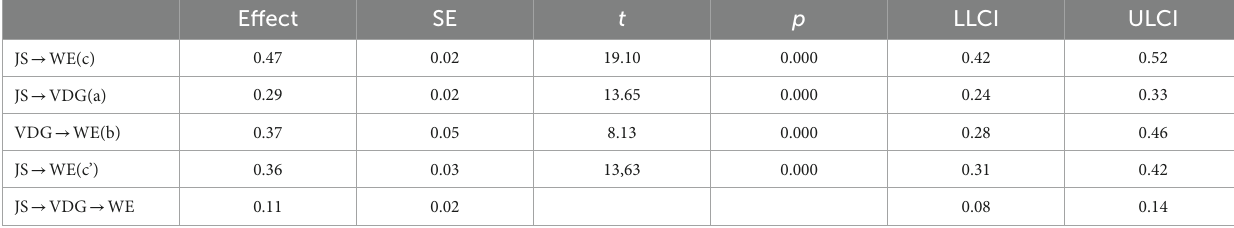
Figure 1. The total effect of job satisfaction on work engagement was